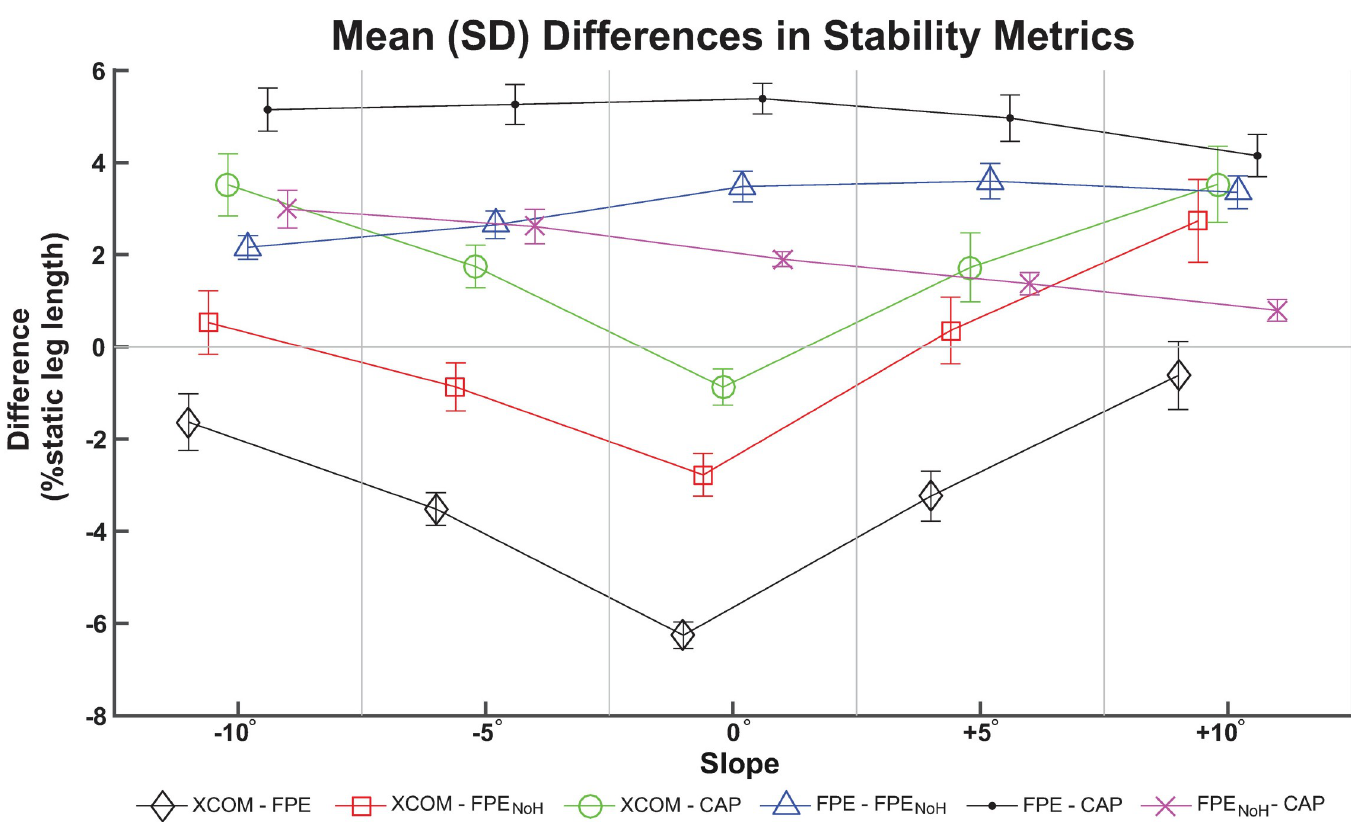
Fig 3. Mean ( ± SD) differences between stability metrics. Mean ( ± SD) signed differences between each pair of stability metrics at each of the slope angles investigated. Comparisons were made between extrapolated center of mass (XCOM), foot placement estimate (FPE), foot placement estimate with no angular momentum (FPE NoH ) and capture point (CAP). Differences were computed by subtracting one metric from the other, e.g., XCOM-FPE denotes that the FPE metric was subtracted from the XCOM metric. Each metric was normalized to percent static (i.e., standing) leg length. Lines connecting data points are solely intended as a visual